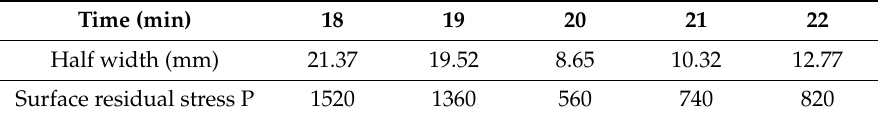
Table 1. Surface residual stress of foam materials at different reaction times.